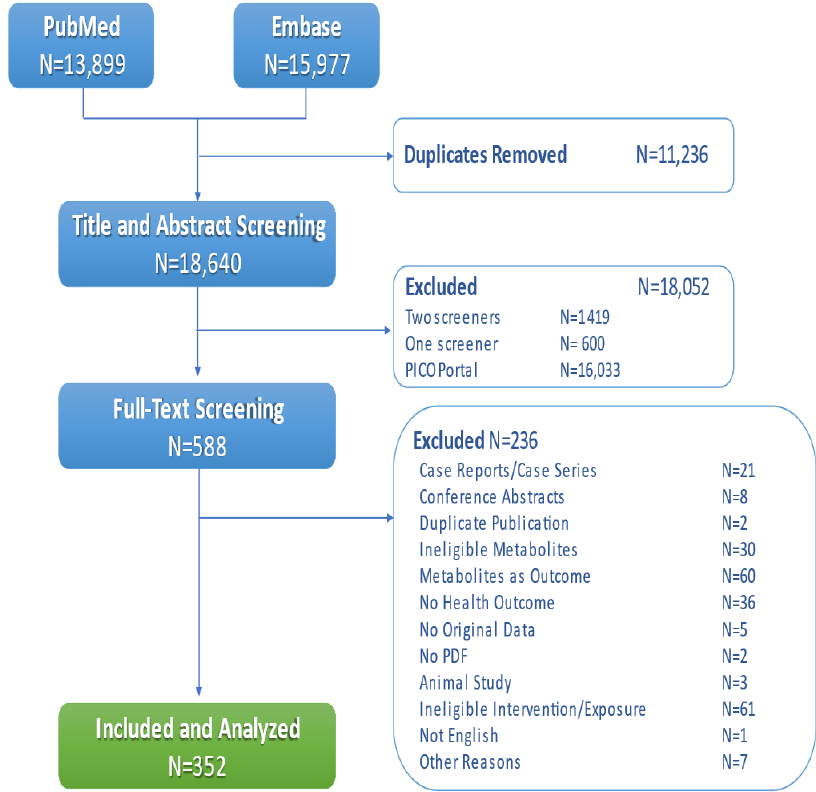
Figure 1. Selection of Included Studies.